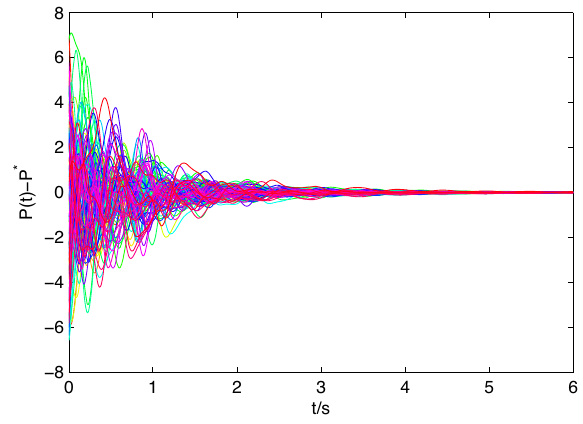
Fig. 3 The response curves of links’ state matrix P